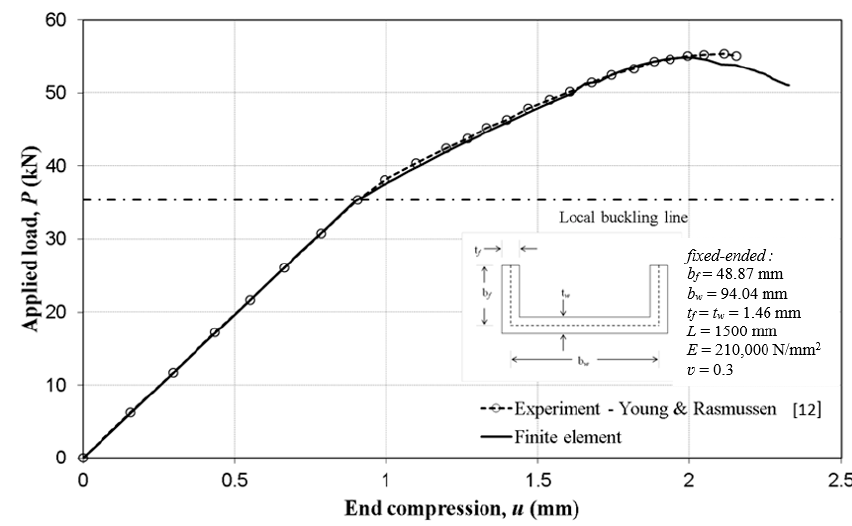
Figure 6. Load–end compression comparisons with experimental tests.